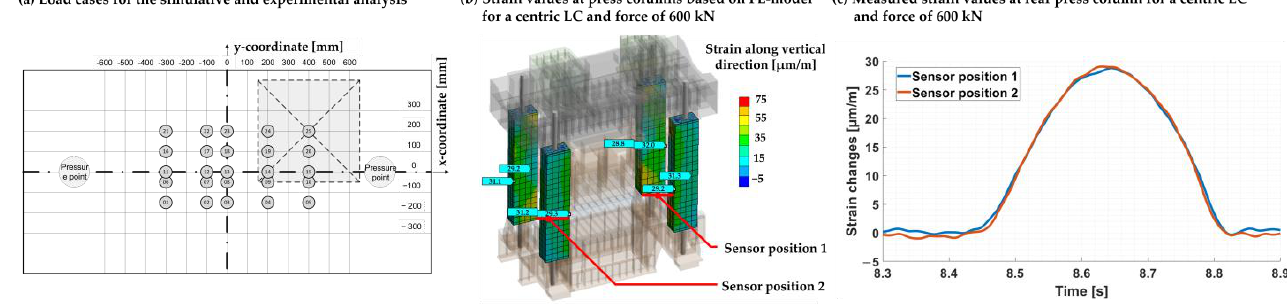
Figure 5. ( a ) Load cases for the simulative and experimental analyses, ( b ) simulated strain distribution at press columns for a centric LC, and ( c ) experimentally measured strain at the defined sensor position for an eccentric load case.